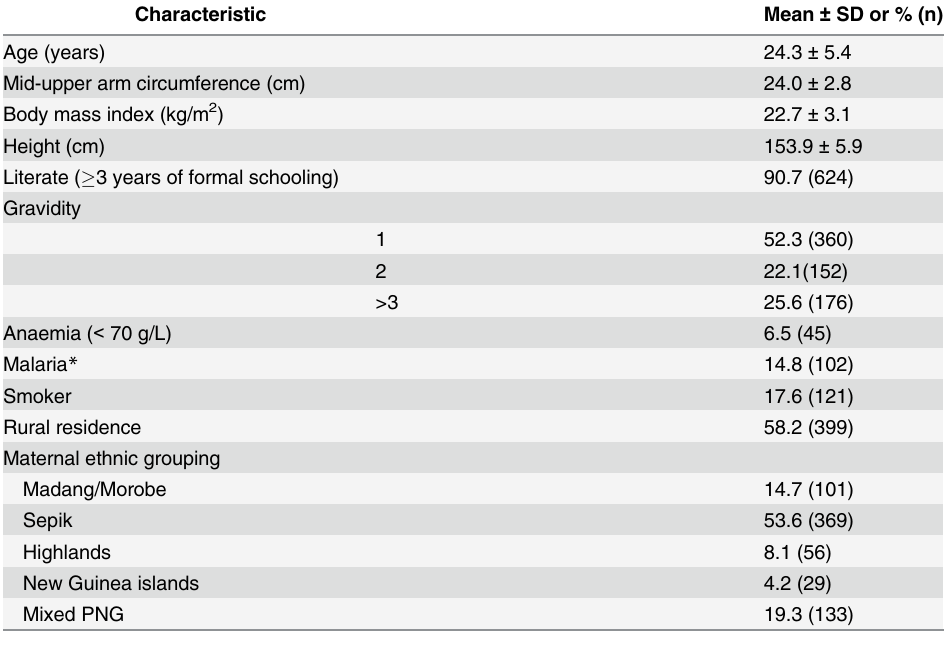
Table 2. Enrolment Characteristics of Pregnant Women (n = 688) from Rural Madang Province, Papua New Guinea, 2009 –